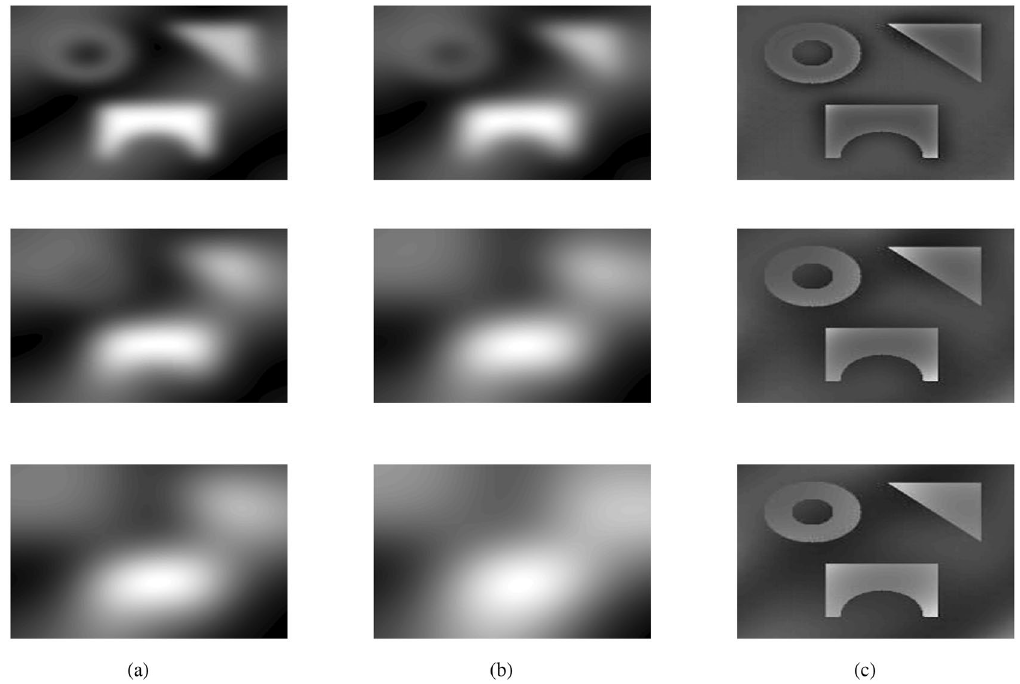
Figure 2. A demonstration of the dual filter formulation on gray image suffered from intensity inhomogeneity with different values of k . The first column ( a ) shows the inhomogeneity covered by first filter, the second column ( b ) shows the inhomogeneity covered by the second filter, and the last column ( c ) shows the inhomogeneity-free images. Furthermore, the first row deliberates the outcomes for k = 10 , the second row deliberates the outcomes for k = 20 , and the last row demonstrates the results for k = 30 .